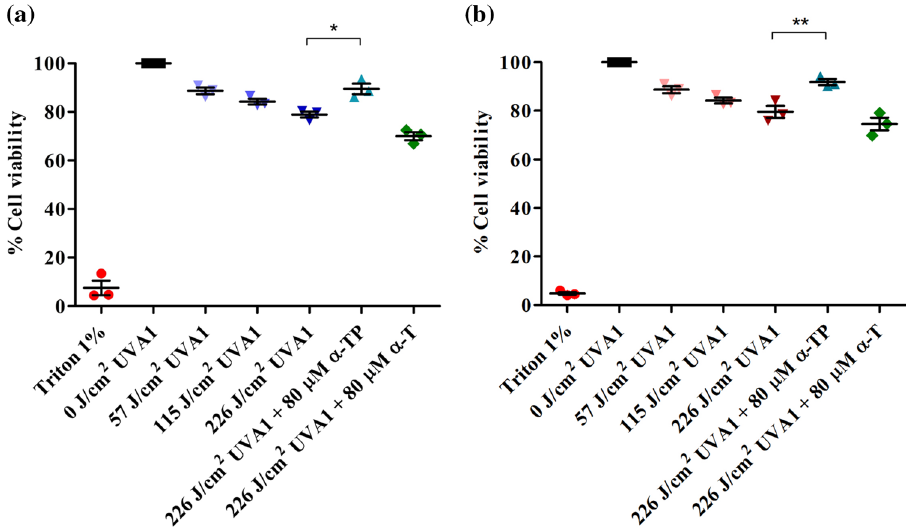
Figure 5. Dose–response experiments for cell viability and effect of pre-UVA1 antioxidant treatment. HaCaT keratinocytes were treated with positive control (Triton 1%), unirradiated, exposed to 57, 115, 226 J/cm 2 UVA-1 or treated for 24 h with 80 μM α-TP or α-T before UVA1 exposure (226 J/cm 2 ). Viability was assessed after 24 h by Alamar Blue ( a ) or the Neutral Red assays ( b ). Note: *p < 0.05. **p < 0.01. Data represent mean ± SD of three individual